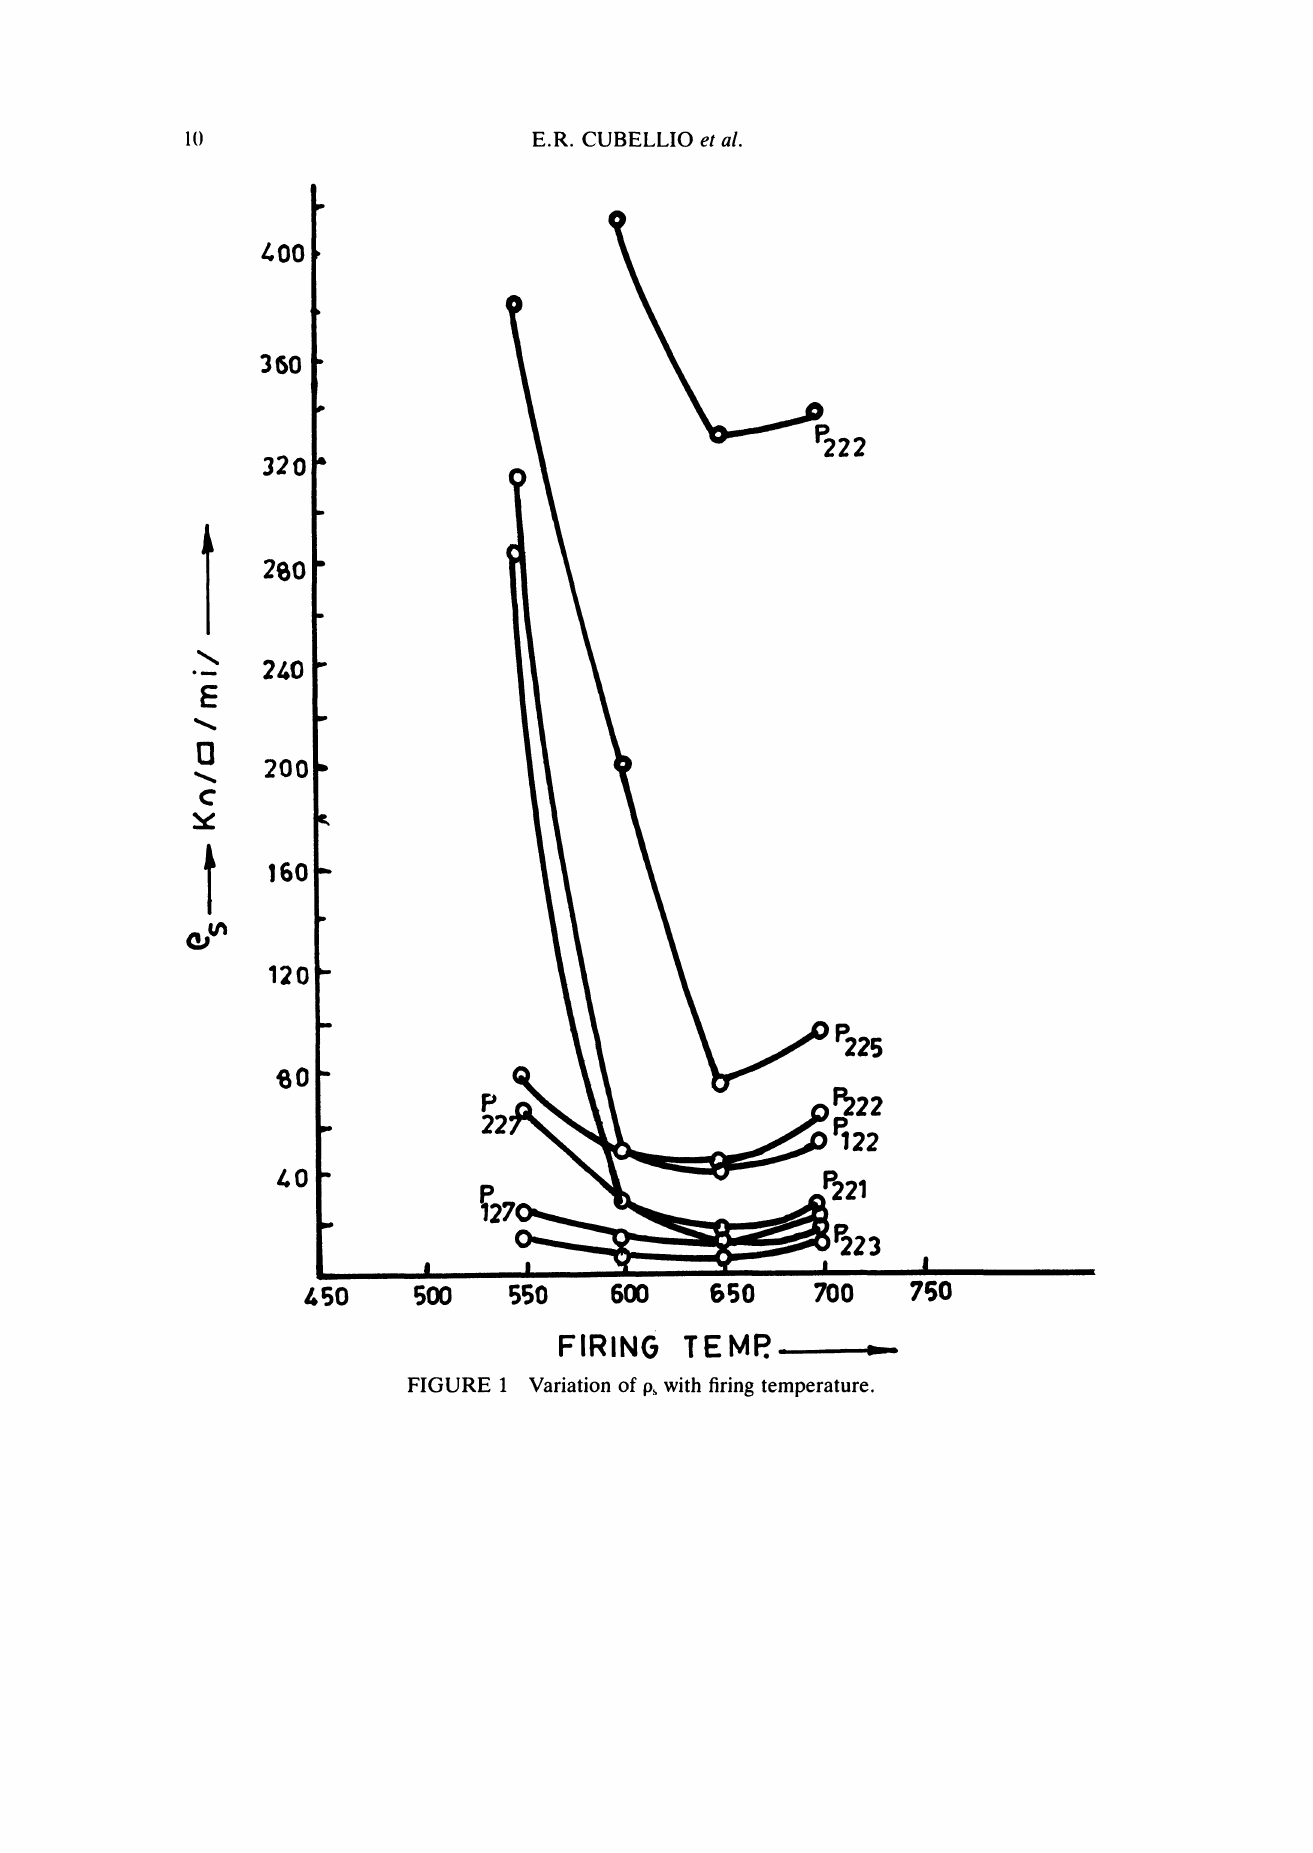
FIGURE Variation of p, with firing